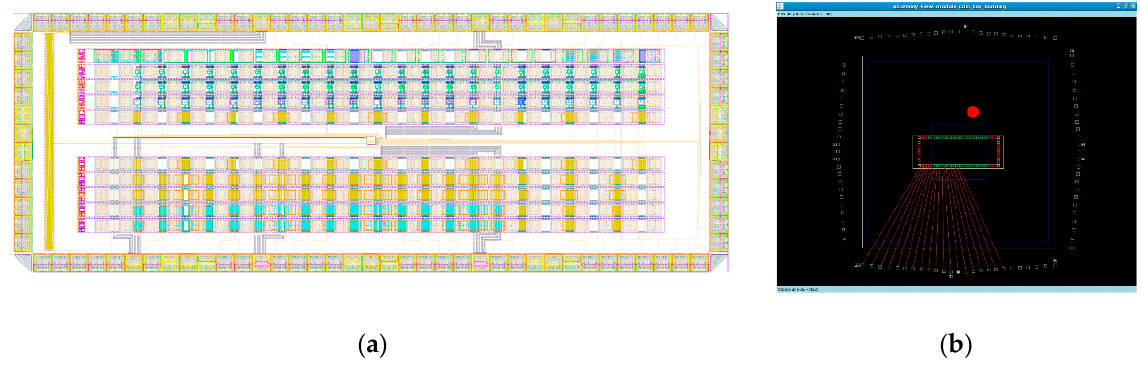
Figure 8. ( a ) Layout implementation of the entire test chip; ( b ) bonding diagram